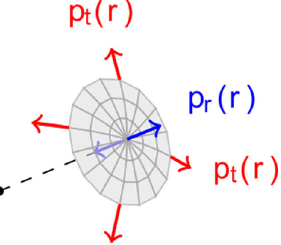
Fig. 1 The radial pressure p r ( r ) and the tangential pressure p t ( r ) at a distance r from the center of the system (31). Spherical symmetry imposes only the equality of the two tangential pressures